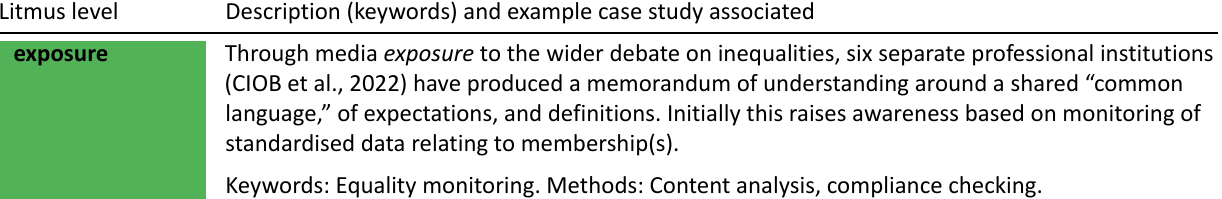
Table 3. Definitions of positive interventions to segregation and inequalities. Litmus